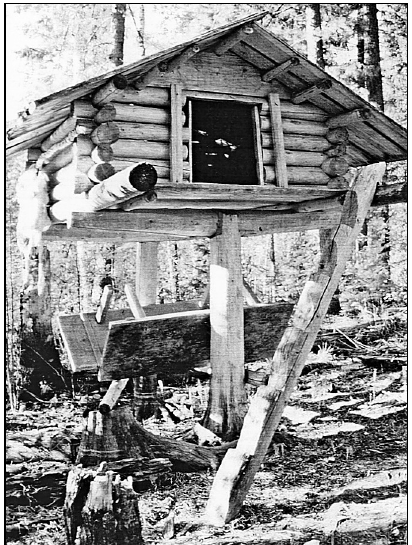
Figure 3 A sacred shrine in the forest not far from the local yurt settlement; it is the home of guardian spirits where ceremo- nies take place and around which hunting, fishing and gathering are